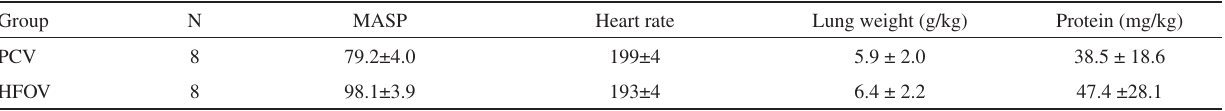
Table 2 - Characterization of the hemodynamic repercussion (mean arterial systemic pressure, and heart rate), lung weight (normalized to body weight) and total protein present in alveolar lavage (normalized to body weight) in both study groups. Values given as mean ± SD Group N MASP